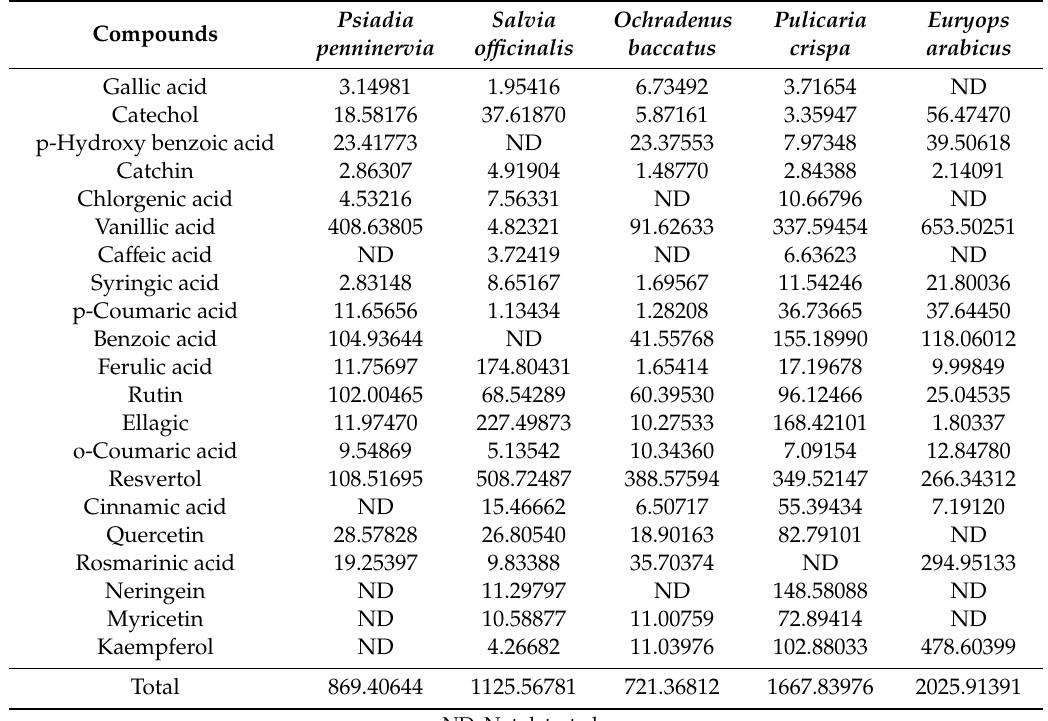
Table 2. Components of phenols and flavonoids in the five medicinal plant extracts (mg / kg).